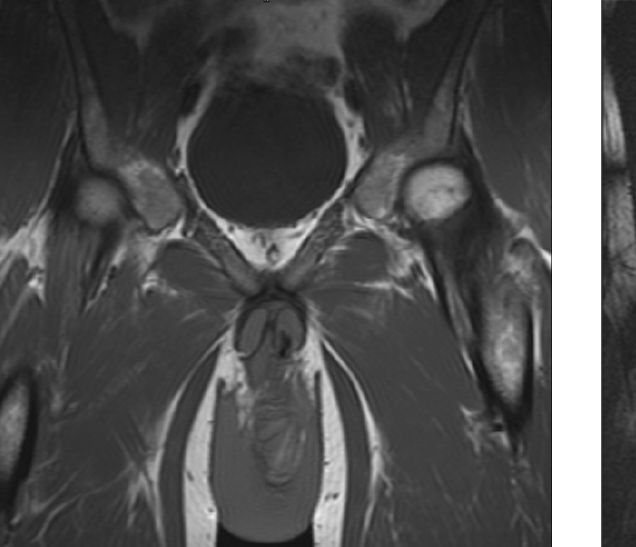
Figure 2 - The heterogeneous left scrotal hematoma and low signal left corpus cavernosum hematoma are more conspi- cuous on this T2 coronal